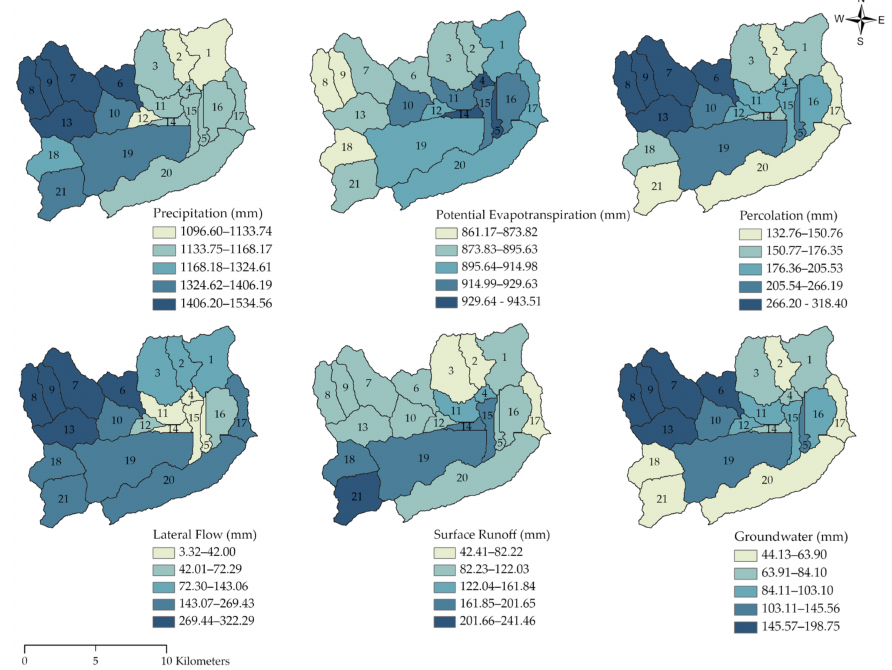
Figure 6. Spatial distribution of water balance components at sub-basin level in